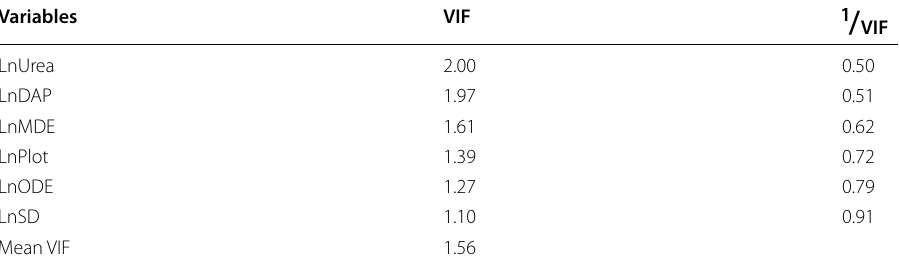
Table 4 VIF of the explanatory variables of the stochastic frontier production function model. Source: Computed from Field Survey Data,